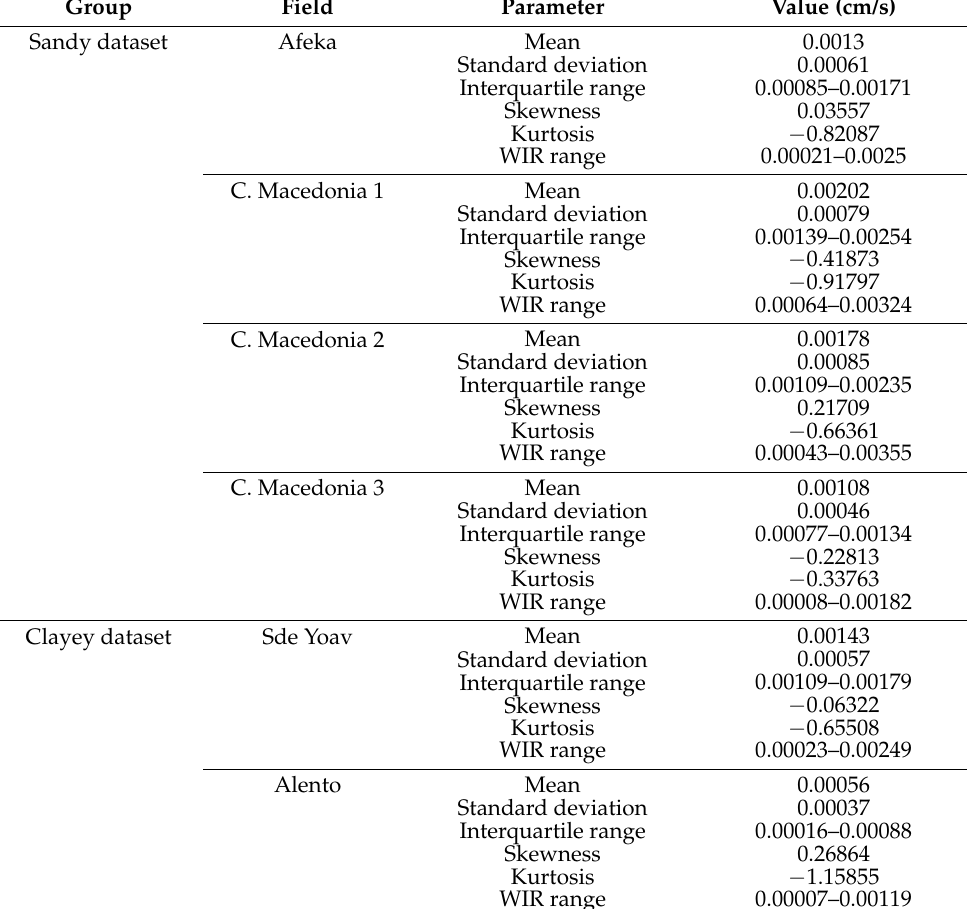
Table 3. Dispersion statistics per field.